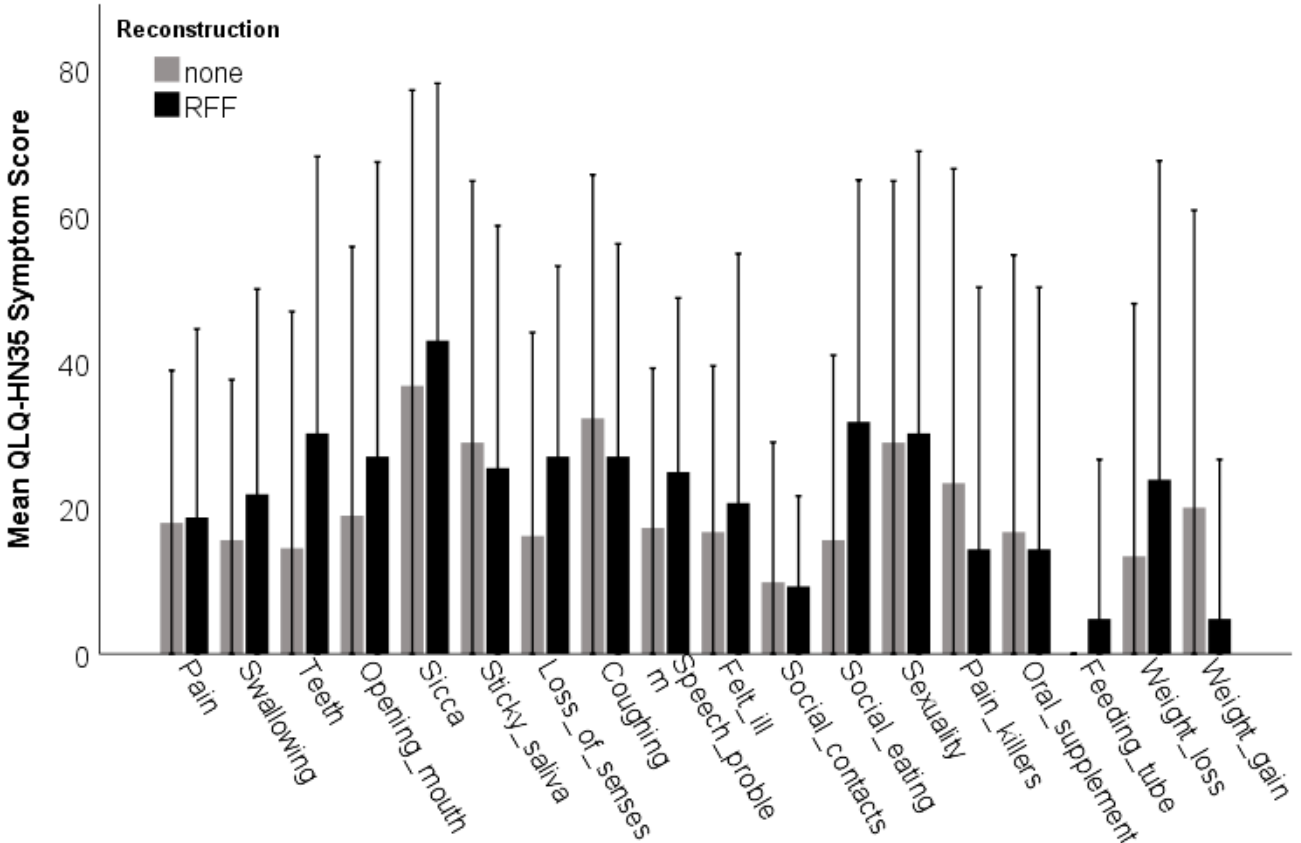
Figure 5. Results of the EORTC QLQ-HN35 for primary closure and RFF reconstruction compared.